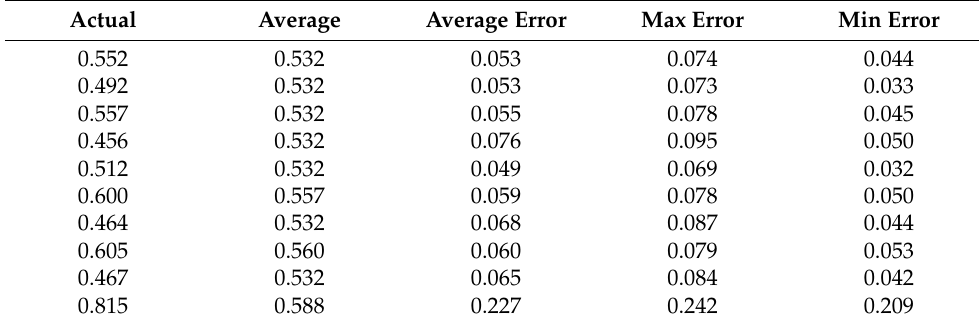
Table A35. Set 1, trials 21–30 data (average actual PR